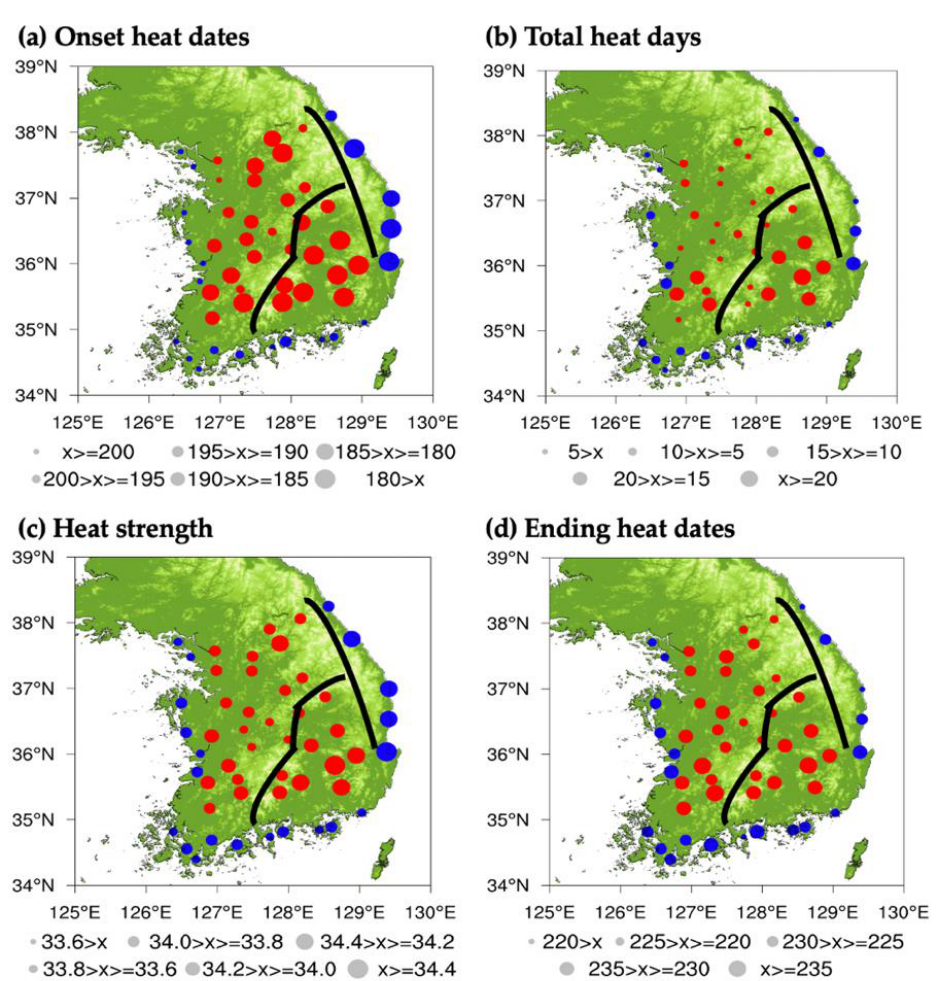
Figure 1. Climatological means of ( a ) onset heat dates (Julian days), ( b ) total heat days (days), ( c ) heat strength ( ◦ C), and ( d ) ending heat dates (Julian days). The red and blue dots indicate inland and coastal stations, respectively. The size of each circle shows the value of each heat-related indicator over the weather stations; refer the legend below each map. “x” in the legend means each relevant indicator. The green shading represents the altitude of the topography: brighter green indicates a higher altitude. Black thick lines indicate the Sobaek and the Tabaek mountain ranges from the left in order.